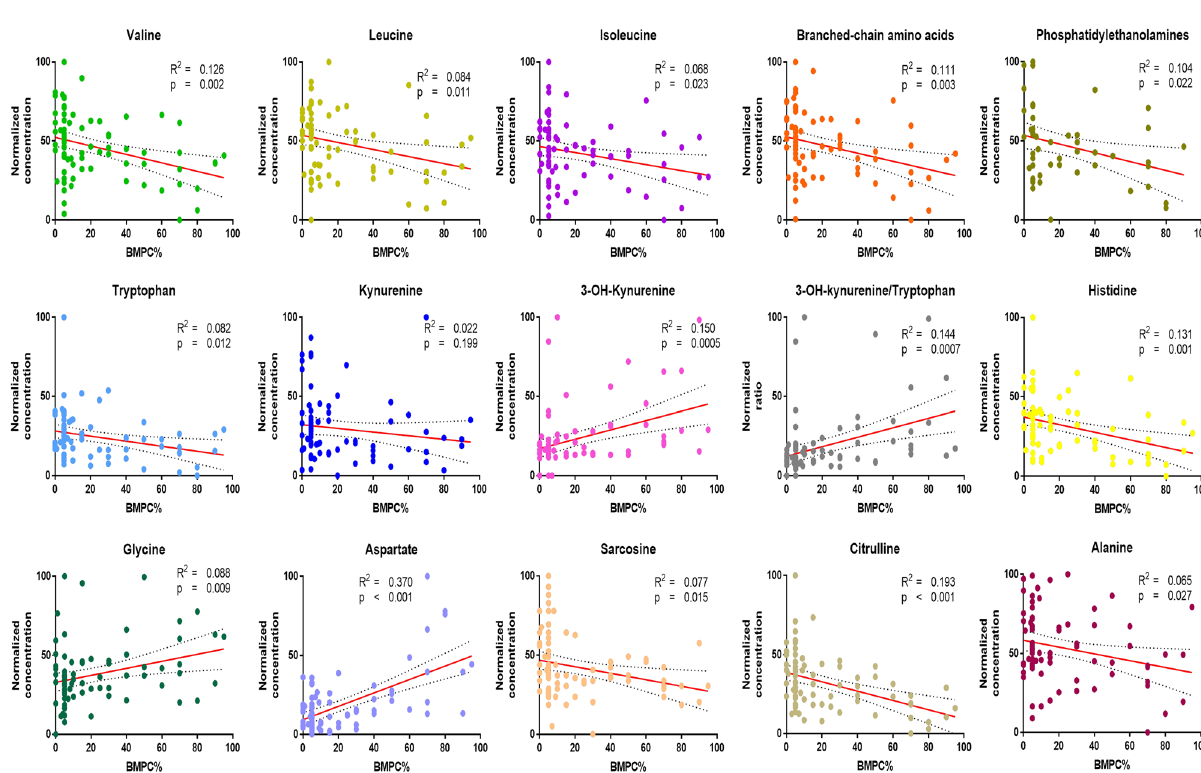
Figure 7. XY-correlation plots comparing the normalized concentrations of various amino acids and metabolites in the bone marrow plasma of patients with MGUS and MM and the percentage of clonal PCs in their bone